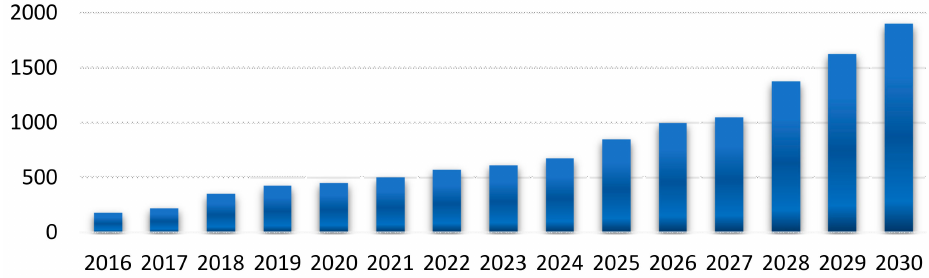
Figure 9. Annual UK investment in charging infrastructure (£millions) [35].